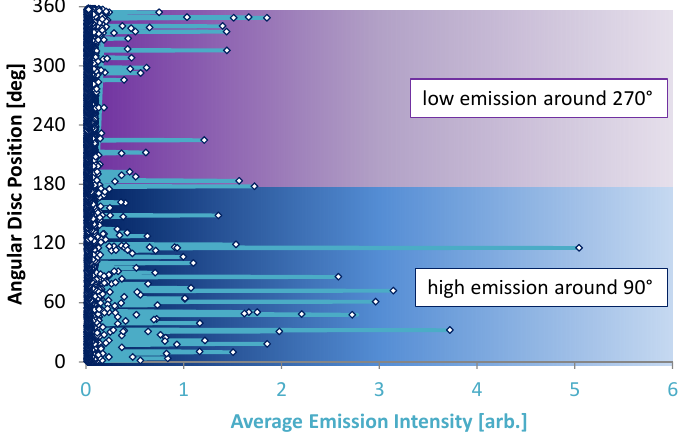
Figure 5. Average of phosphor screen intensity as a function of emission intensity and disc position.